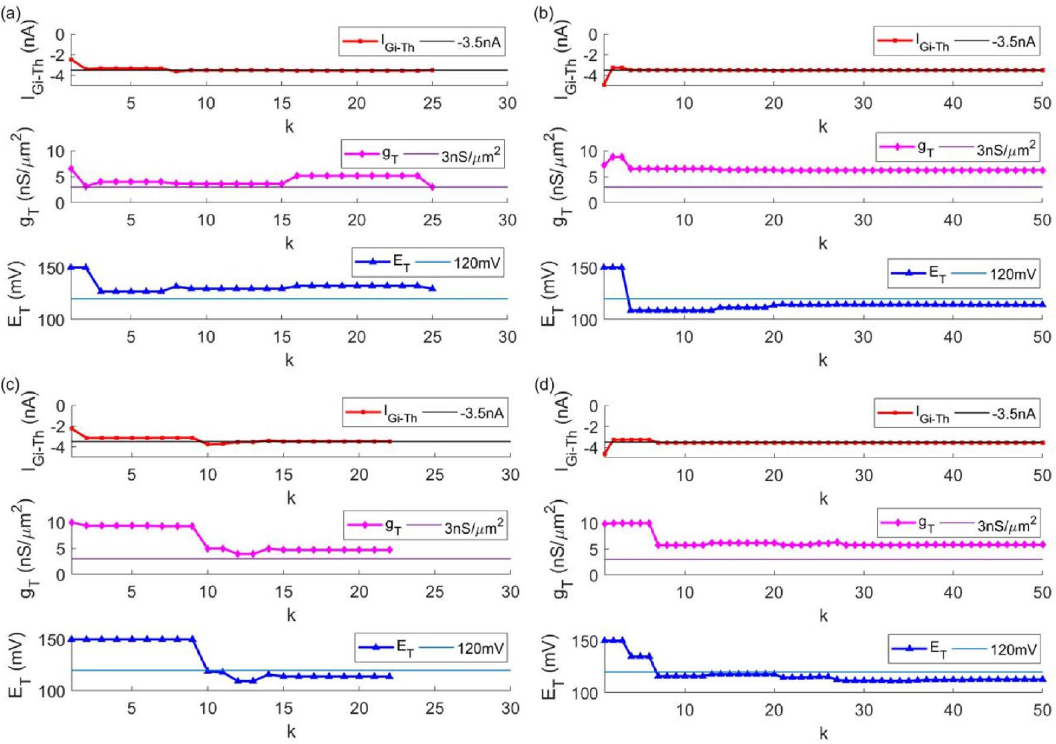
Figure 7. The fitting process of the three key parameters I Gi → Th , g T and E T of the TC model. The inertia weight is: ( a ) a constant ( b ) a determined linear function ( c ) the first single dynamic nonlinear concave function ( d ) the second single dynamic nonlinear concave function.